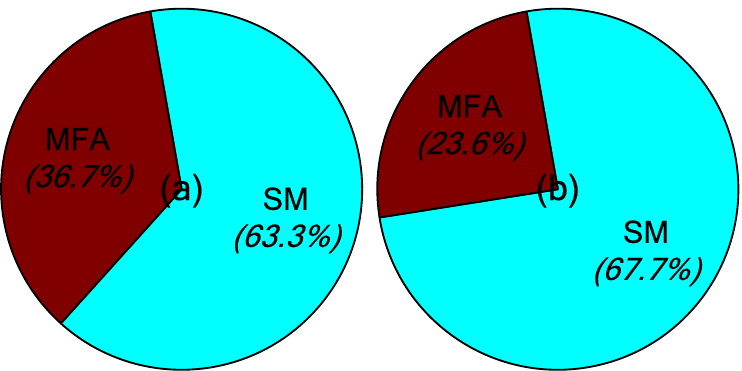
Figure 13. The contribution percentages of various methods to feedback gain: ( a ) Actuators a / b , ( b ) actuator c.